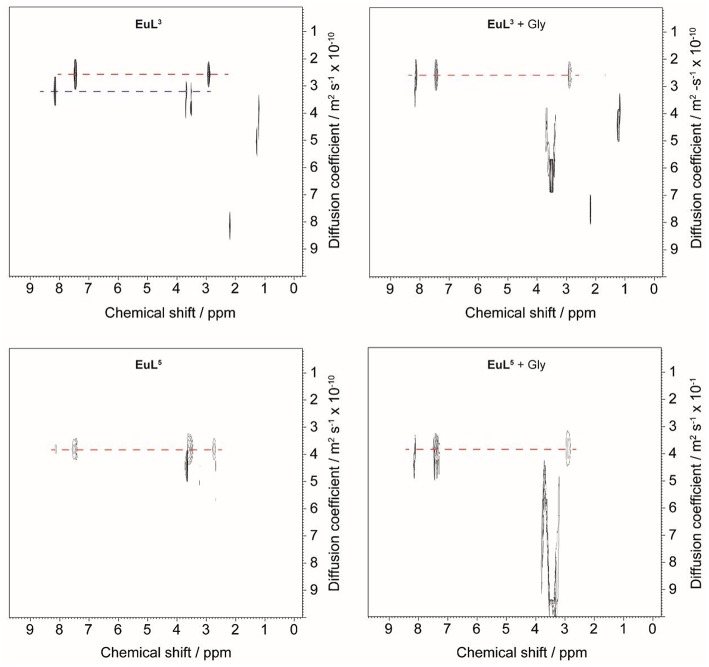
1H DOSY NMR of EuL3 (top) and EuL5 (bottom) in D2O before (left) and after (right) addition of 50 equiv. Gly.